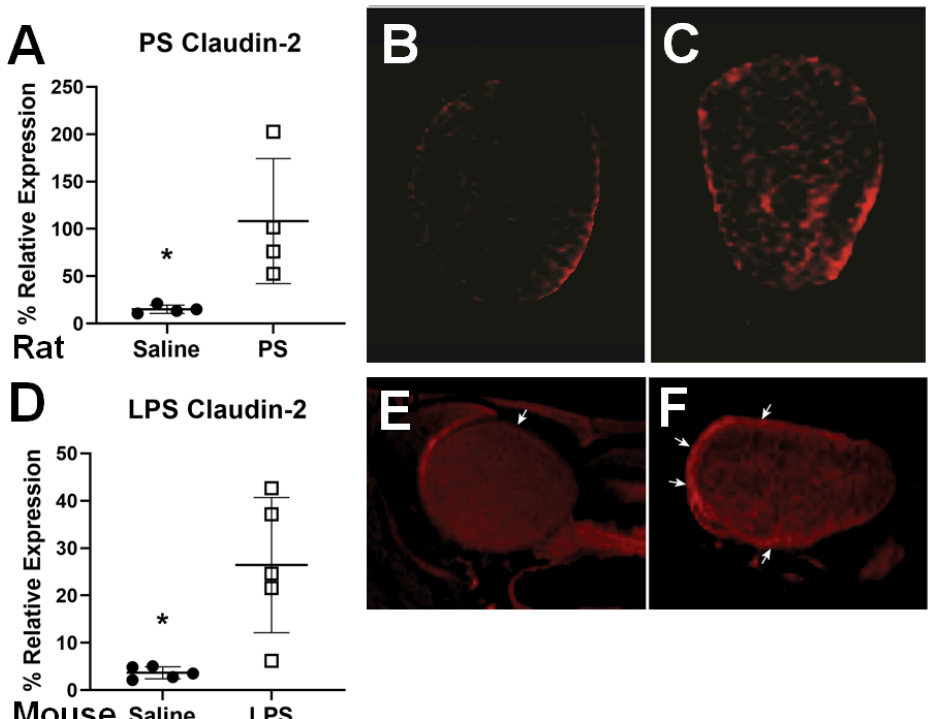
Figure 3. Molecular-targeted MRI (Mt-MRI) of claudin-2 in a rat PS-induced cystitis model ( A – C ) or URO-MCP-1 transgenic mouse model ( D – F ). ( A ) Quantitative assessment of claudin-2 probe expression in a rat PS-induced cystitis model. There was a significant difference between saline (closed circles) and PS groups (open squares) (* p < 0.05). Representative mt-MR images in saline- ( B ) or PS-treated ( C ) rat bladders administered with a claudin-2 Gd-based probe. Note high expression of claudin-2 in frame C. ( D ) Quantitative assessment of claudin-2 probe expression in a mouse URO-MCP-1 LPS-induced IC model. There was a significant difference between saline (closed circles) and LPS groups (open squares) (* p < 0.05). Representative mt-MR images in saline- ( E ) or LPS-treated ( F ) mouse bladders administered with a claudin-2 Gd-based probe. Note high expression of claudin-2 in frame R (white arrows). Figures were modified from those published in Refs. [39,46].